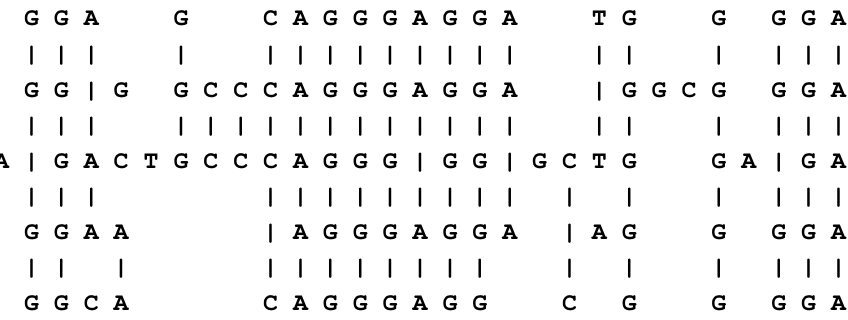
Figure 3. A “good” alignment amongst five DNA